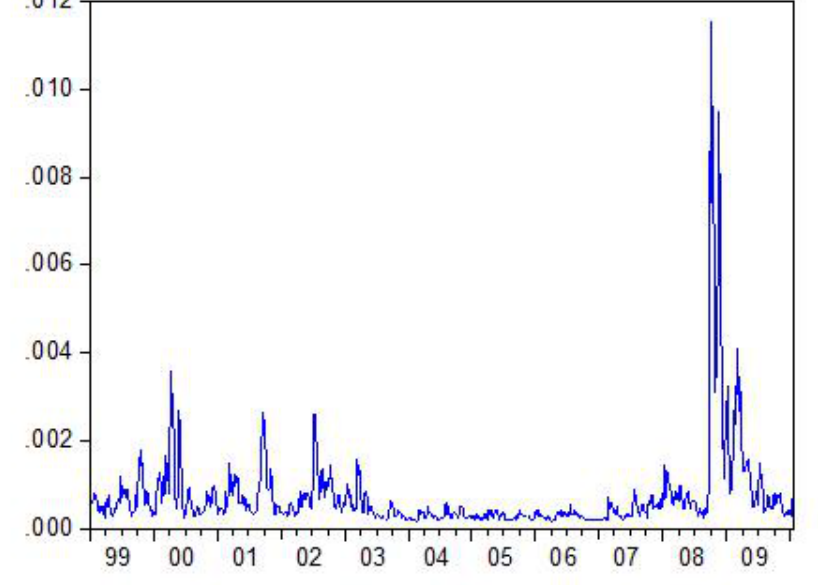
Fig. 1: GARCH(1,1) estimate of the variance of S&P500 return